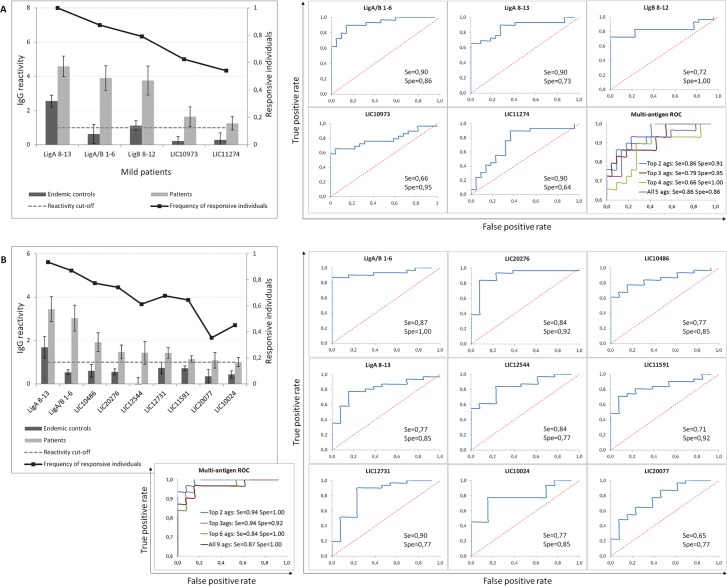
Serodiagnostic antigens identified for patients with mild and severe leptospirosis.Histograms plot the average normalized intensity (Y axis) of each antigen (X axis) for hyperendemic controls (dark gray bars) and patients with mild (A) or severe (B) disease (light gray bars), with the frequency of responsive individuals (black line, secondary axis). Error bars indicate S.E. Single or multi-antigens ROC curves of the identified serodiagnostic antigens for mild (A) or severe (B) groups are shown with sensitivity and specificity rates.